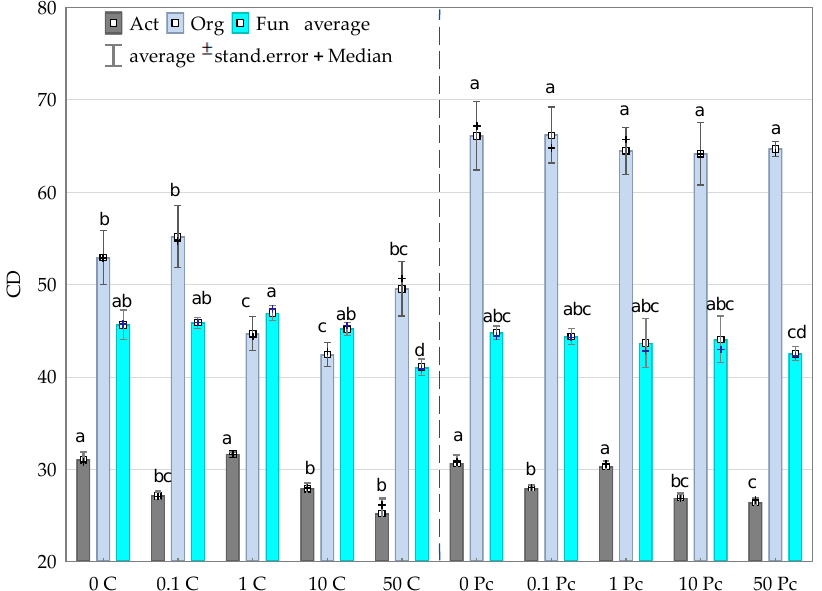
Figure 3. Colony development index (CD) for Org—organotrophic bacteria, Act—actinomycetes and Fun—fungi in soil contaminated with increasing doses of o -cresol during 15, 30 and 45 days of the experiment (average value); Homogeneous groups denoted with letters (a–d) were calculated separately for each group of microorganisms; 0; 0.1; 1; 10; 50—doses of o -cresol (mg kg −1 DM of soil); C—control; and Pc— Perna canaliculus (for abbreviations see Figure 2).